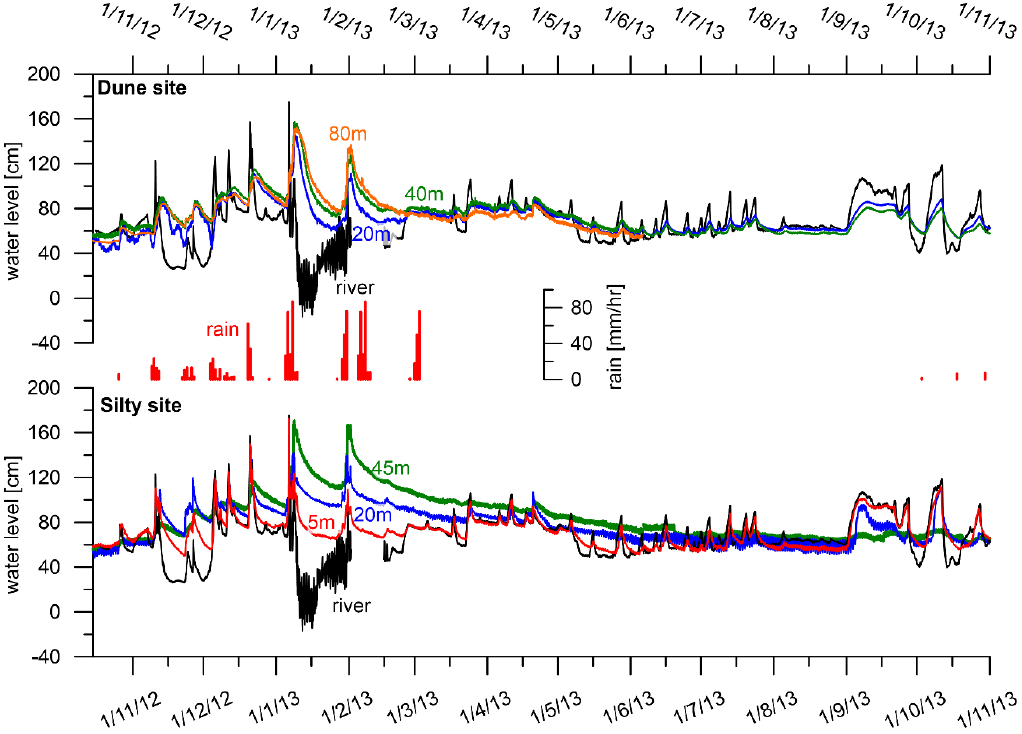
Figure 3. Groundwater levels at the Dune site (top) and at the Silty site (bottom), south and north of the river, respectively, compared with river level. Numbers denote distance in meters from the river. Daily precipitation at 5 km from the sea is also shown (red bars). Short-period zoom-ins are shown in Figure 4.